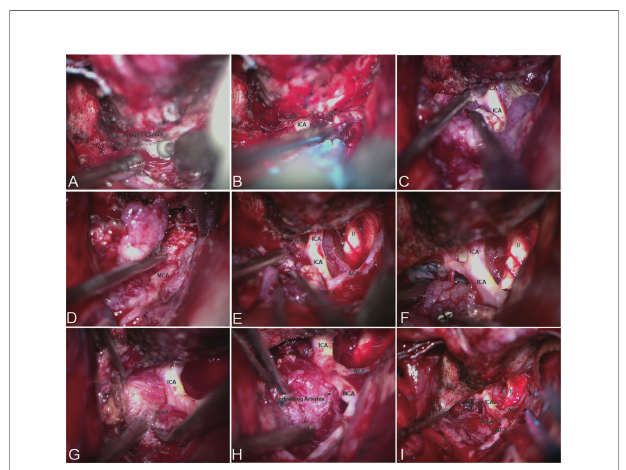
FIGURE 2 | Bidirectional dissection technique applied in ACM. (A) Extradural anterior clinoidectomy. (B) The proximal ICA can be localized in the medial of the anterior clinoid. (C) Forward dissection was started from the identi fi cation of the proximal ICA and along the course of the ICA. (D) Reverse dissection was initiated after split the Sylvian fi ssure. (E – H) Forward dissection would be applied again after debulking and resection most of the tumor. (I) Total resection and artery protection can be achieved by bidirectional